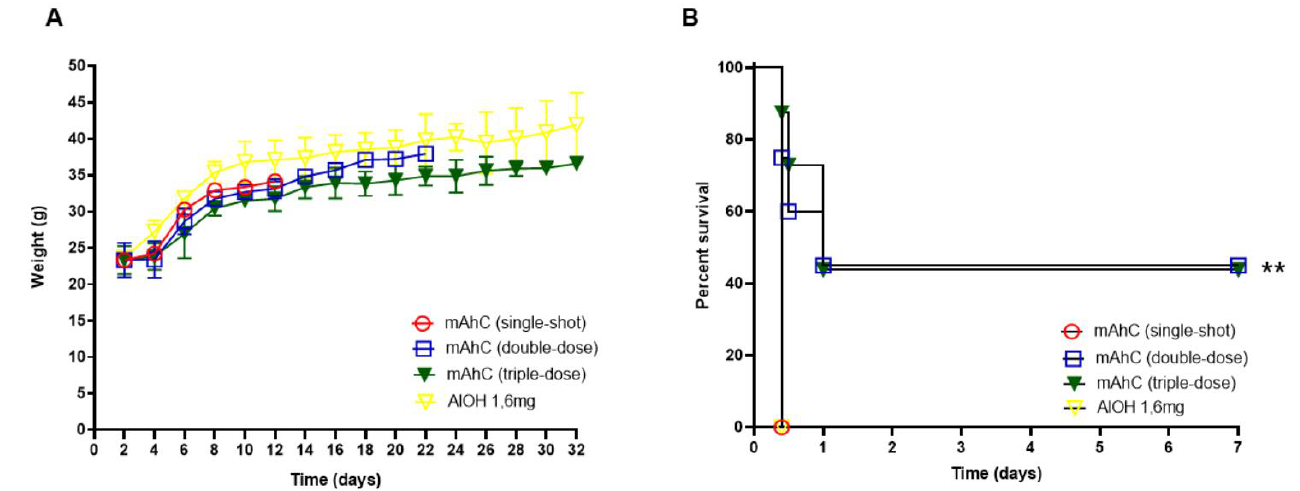
Figure 2. Determination of the number of mAhC doses in CY-untreated mice. ( A ) Bodyweight monitoring of CY-untreated mice. Data are expressed as the mean and standard deviation. p < 0.05). ( B ) Survival curve of mice subjected to A. baumannii challenge (4.0 × 10 8 CFU/mL). The log-rank test (Mantel–Cox test, with six animals per group) determined the p -value. (**) p < 0.01.